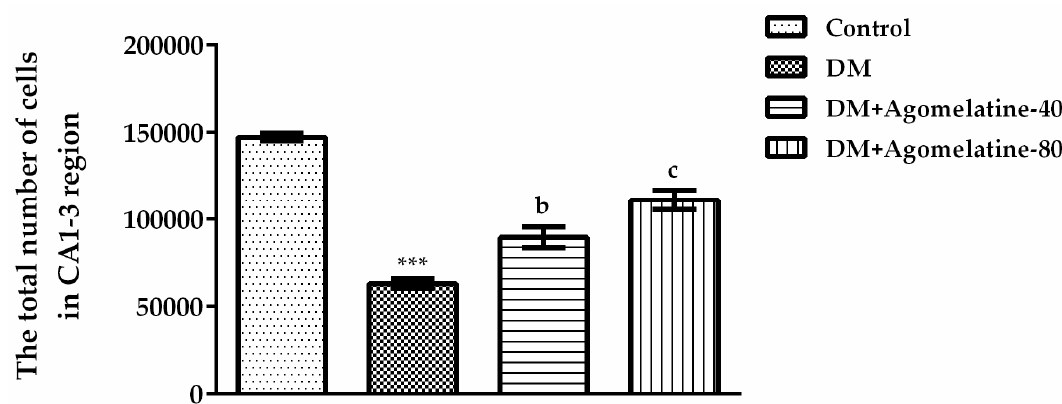
Figure 8. The total number of cells in the CA1–3 region of normoglycemic rats administered saline solution (control) and diabetic rats administered saline (DM), 40 mg/kg agomelatine or 80 mg/kg agomelatine for 2 weeks. Values are given as mean ± S.E.M. Significant difference against control group *** p < 0.001. Significant difference against DM group b p < 0.01; c p < 0.001. One-way-ANOVA, post-hoc Tukey HSD multiple comparison test, n = 6.